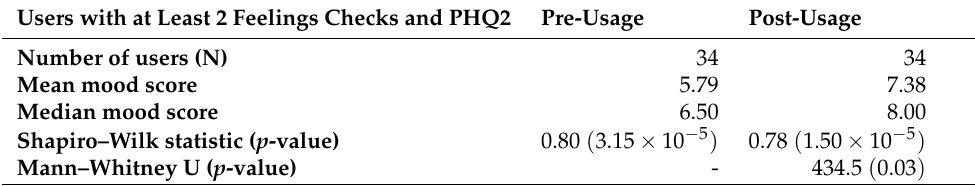
Table 2. Results of Experiment 1 on mood